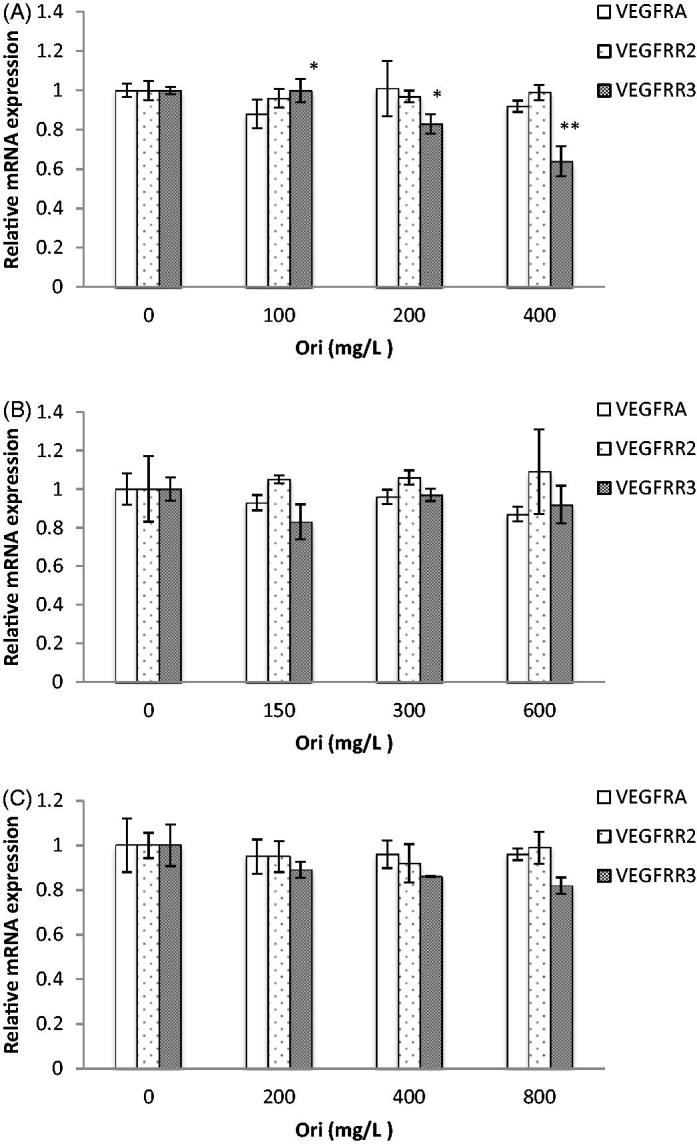
Comparison of gene expression between experiment groups. Note: Asterisks indicate statistically significant differences between different concentration of oridonin groups and the without oridonin group (*p < 0.05; **p < 0.01). Each error bar represents the standard deviations of at least three experiments. A: embryos; B: larvae; C: adult. Ori: Oridonin.